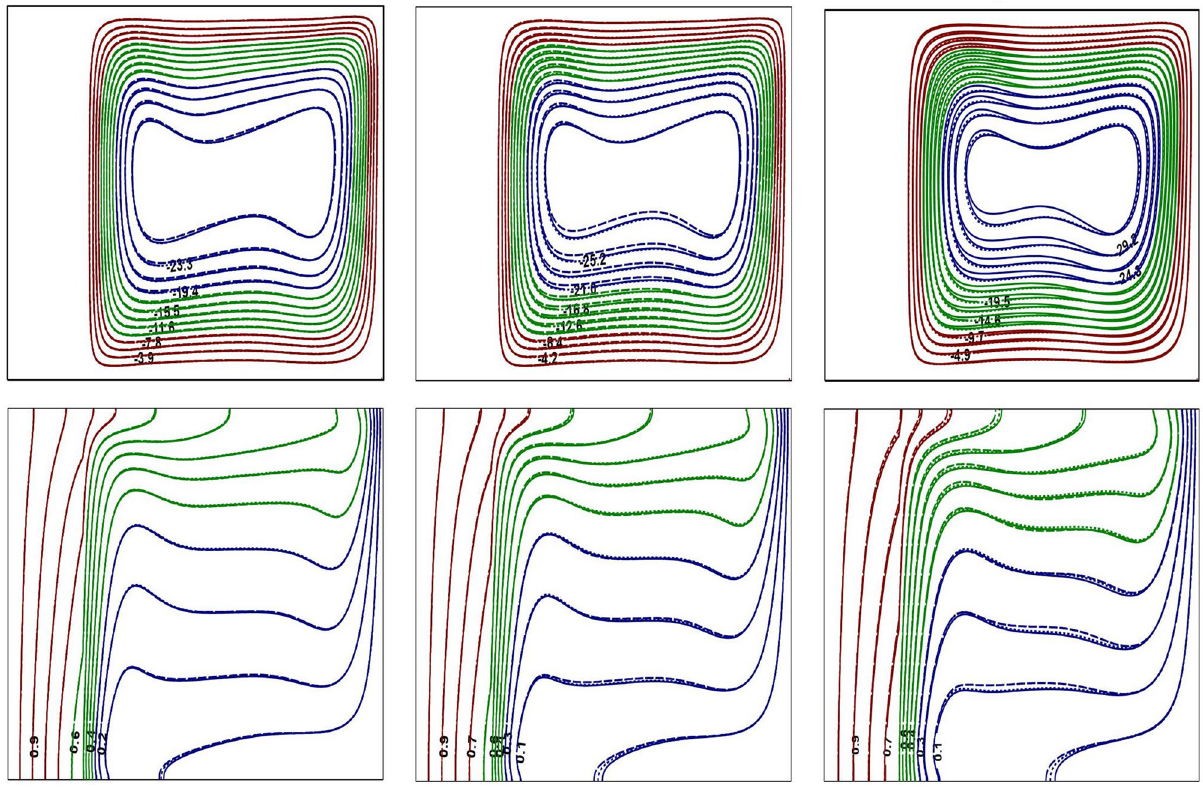
6 , ε = 0.2 and Kr = 5 . φ = 0.05 (left), φ = 0.1